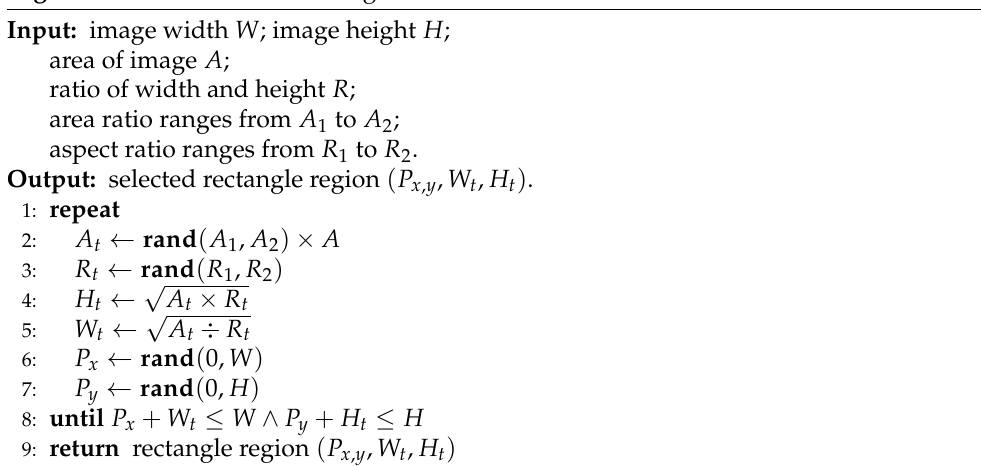
Algorithm 1 Process of Local-Region Selection